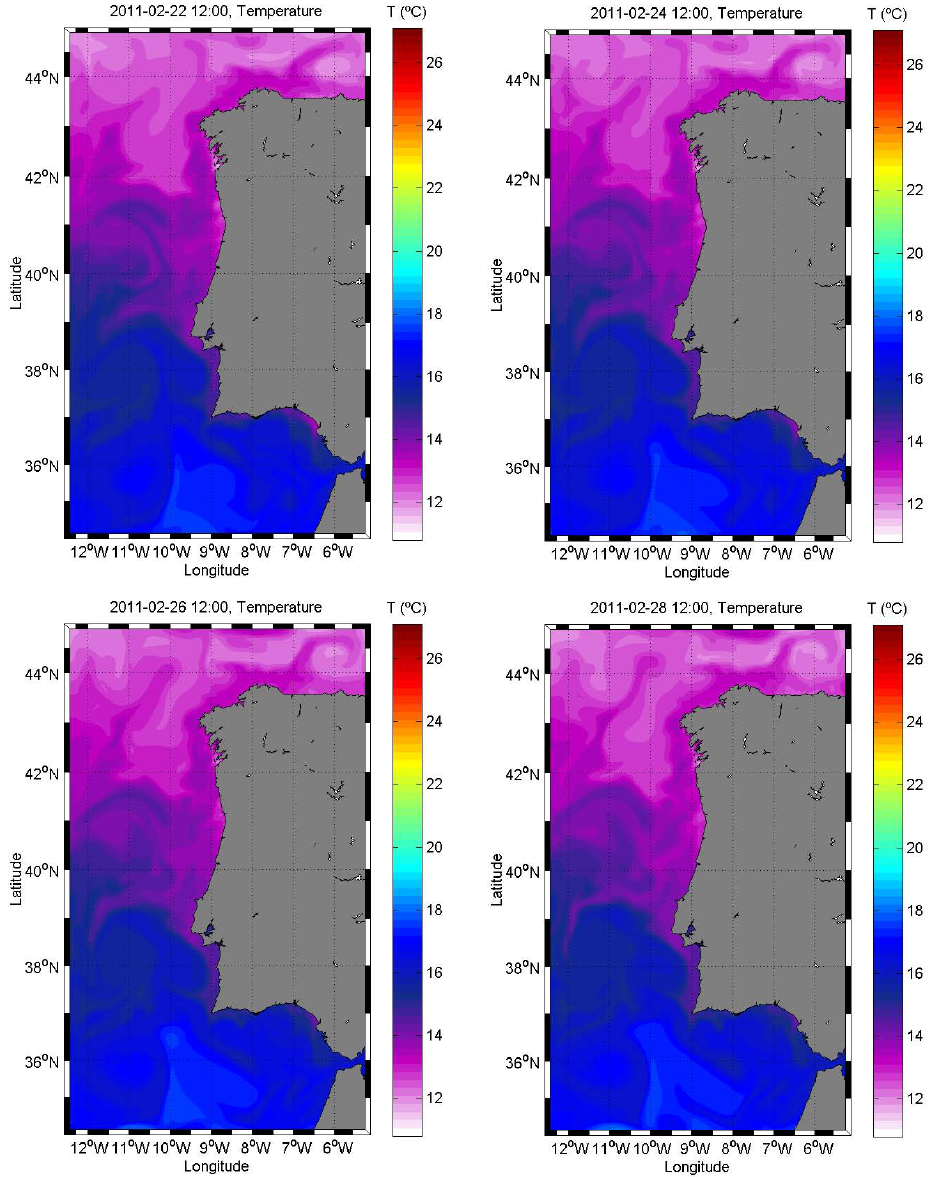
Fig. 2. Snapshots of sea surface temperature predicted by the model from 22 to 28 February